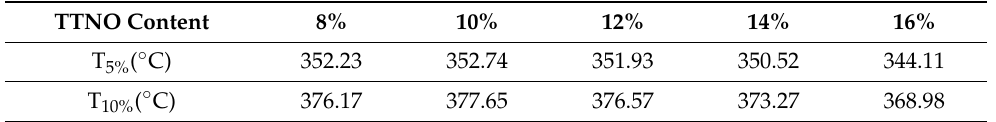
Table 1. TG data of the rubber material of various TTNO